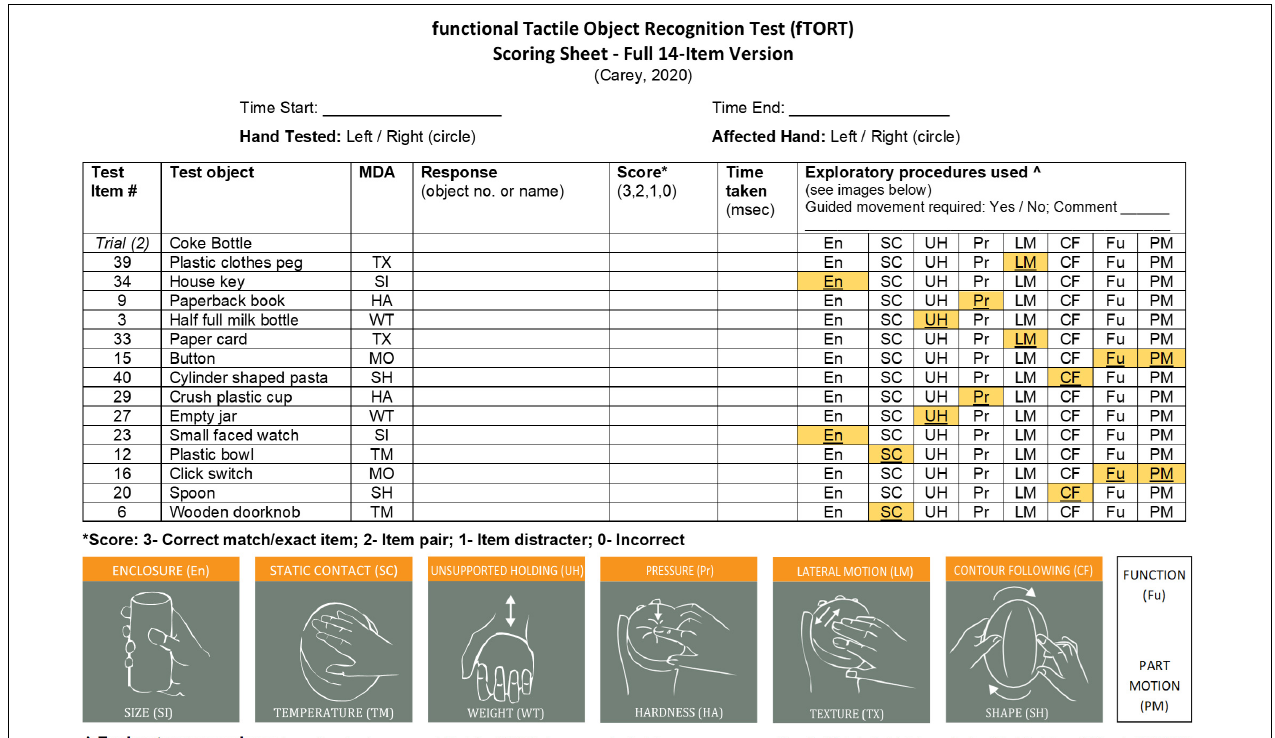
FIGURE 2 | Assessment form for the functional Tactile Object Recognition Test (fTORT). MDA, most diagnostic attribute, i.e., the sensory attribute that distinguishes the test object from the object pair for each of the object sets; TX, texture; SI, size; HA, hardness; WT, weight; MO, motion; SH, shape; TM,